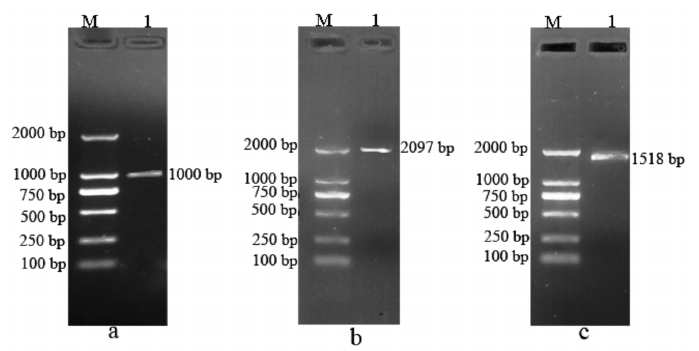
Figure 4. Agarose gel electrophoresis of PCR amplification of BvBTB1 , BvBTB2 , and BvBTB3 . M: D2000 DNA marker, the ladder was fabricated by Tiangen Biochemical Technology (Beijing) Co., Ltd. (Beijing, China); ( a ) BvBTB1 , ( b ) BvBTB2 , ( c ) BvBTB3 ; 1: Target gene. 3.6. Conserved Domains of BvBTB1, BvBTB2, and BvBTB3